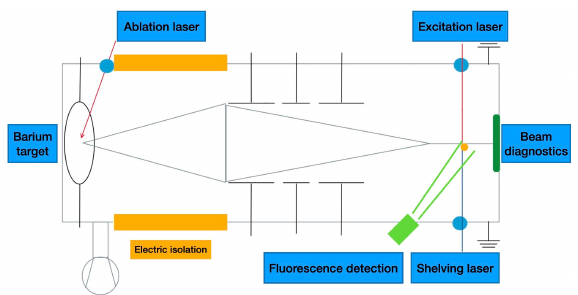
Figure 3. Sketch of the barium ion source vacuum system, consisting of a laser ablation source, an electrostatic isolation, an electrostatic einzellens, 2 lasers for polarization, and a multichannel plate for beam diagnostics.